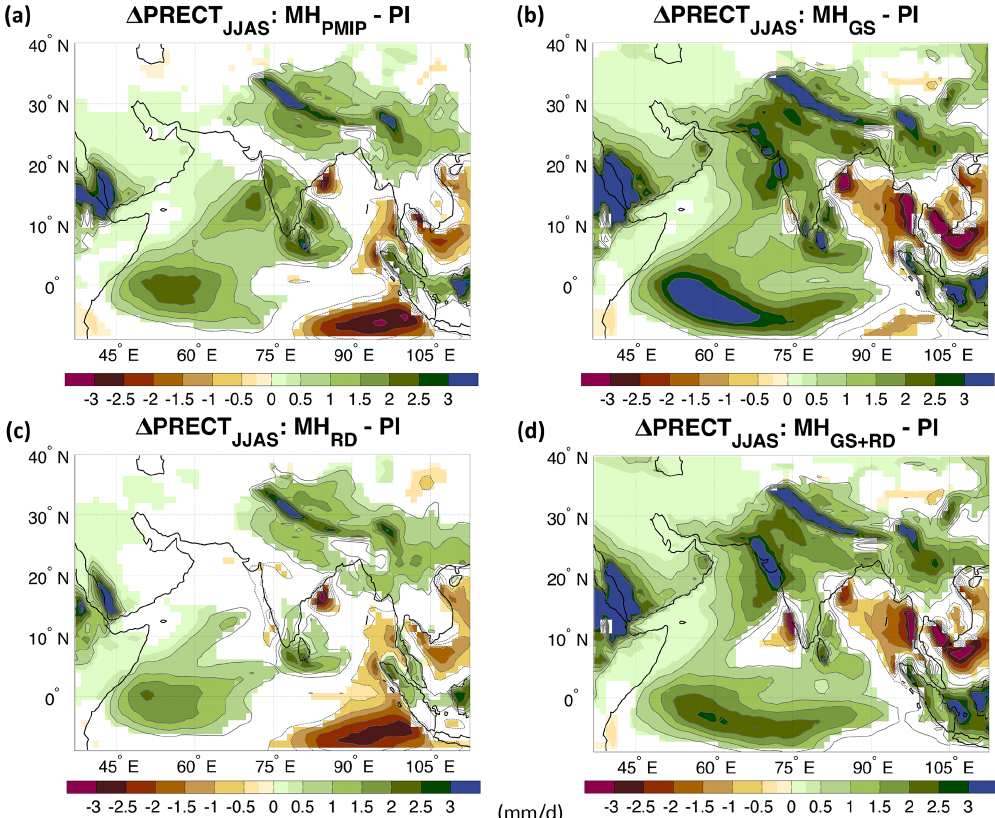
Figure 2. Changes in summer (JJAS) precipitation (PRECT; mm/d) for the (a) mid-Holocene-only orbital forcing (MH PMIP ); (b) the Sahara greening (MH GS ); (c) the dust-only reduction (MH RD ); and (d) the Sahara greening and dust reduction (MH GS + RD ) experiments relative to the PI reference simulation. The contour lines follow the color-bar scale (the 0 lines are omitted for clarity). Only differences significant at the 95% confidence level using the Student t test are